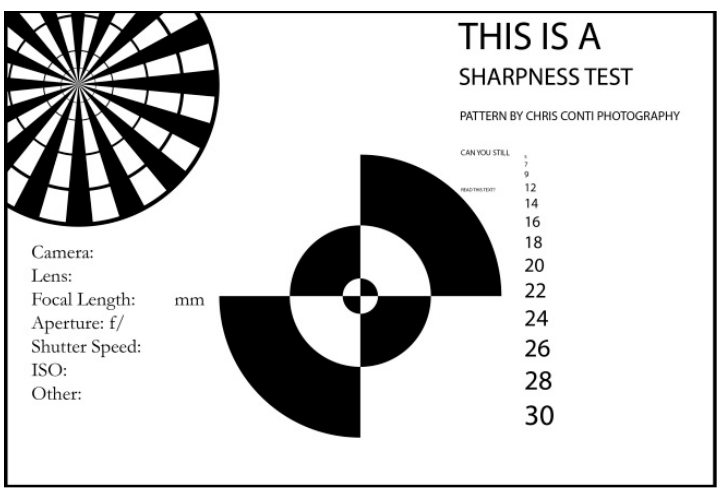
Figure 3. Sharpness test image used to assess focal distance of the Reconyx PC900 and Reconyx HC600 camera-traps. Source: Conti [27].